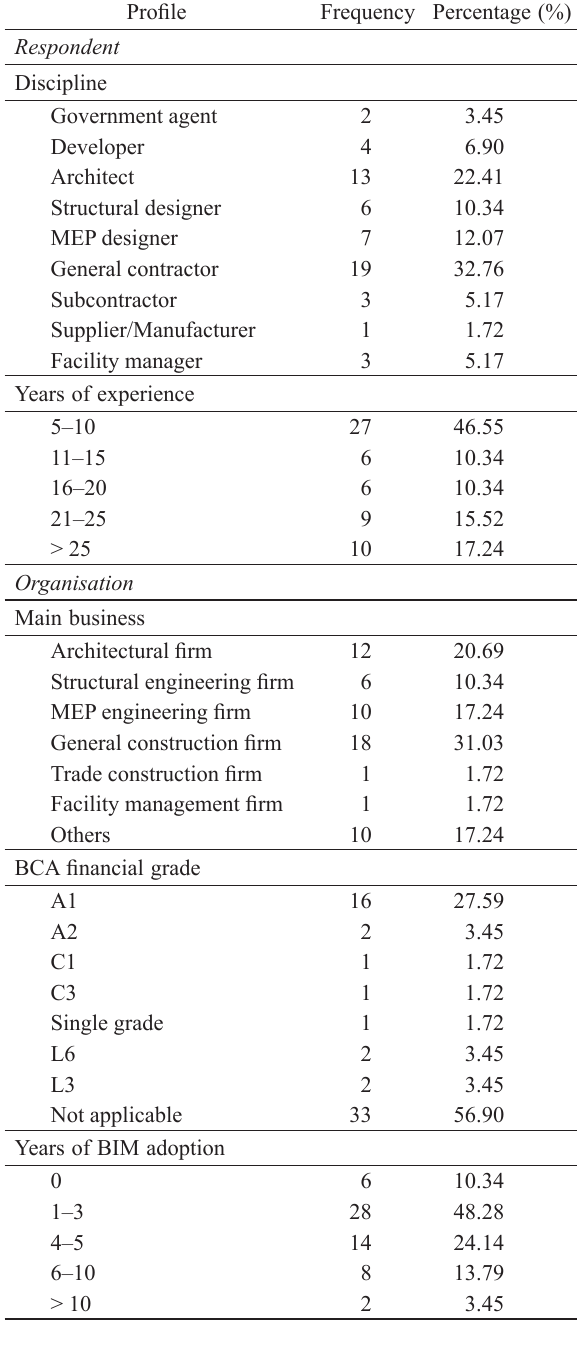
Table 2. Profile of respondents and their organisations Profile Frequency Percentage (%)